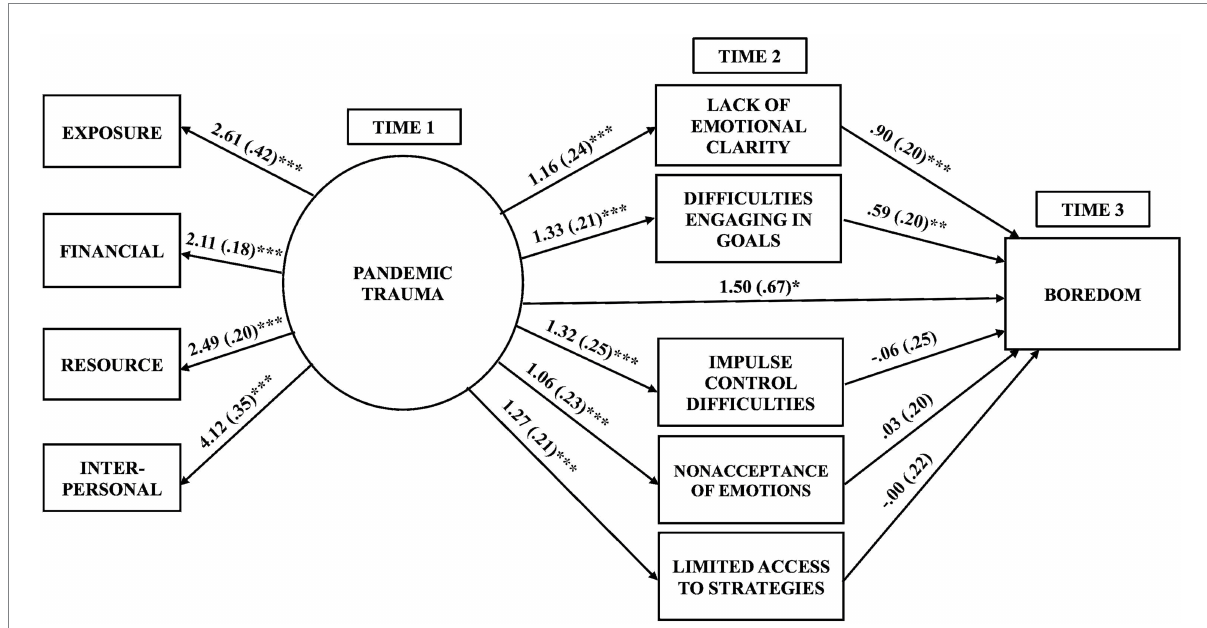
FIGURE 2 Hypothesized mediation model predicting boredom ( N = 344). Hypothesized mediation model ( N = 344) of the pathways to boredom during the coronavirus pandemic. Unstandardized estimates with standard errors in parentheses are shown for all of the paths. Pre-pandemic stress, age, and gender were included as covariates, but are not depicted in the figure (see “Results” for findings related to these covariates). All five mediators at Time 2 were set to covary with each other, but this is not depicted in the model. *** p < 0.001; ** p < 0.01; * p <